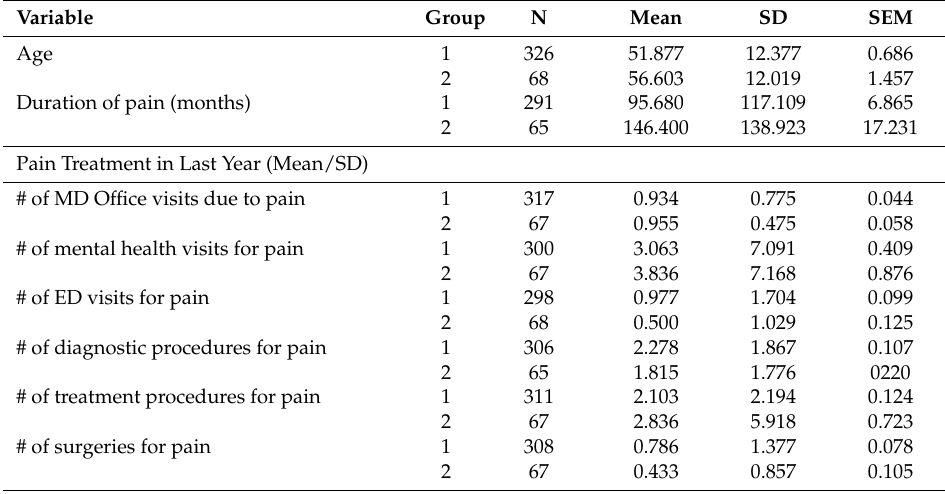
Table 1. Descriptive statistics of each sample site. (Group 1 = Dallas; Group 2 = Richardson).